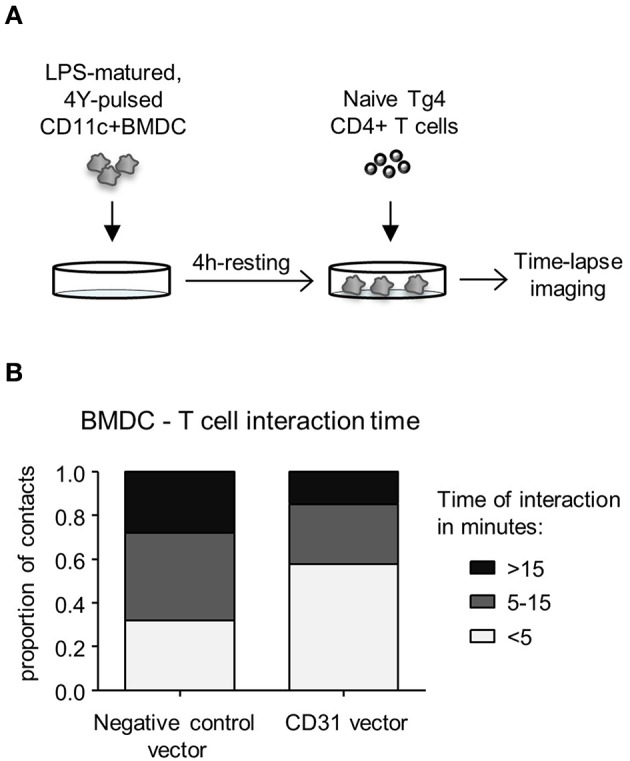
High levels of CD31 on BMDC result in reduced interaction times with CD4+ T cells in vitro. Bone marrow derived dendritic cells (BMDC) were generated over 9 days with 20 ng/ml GM-CSF in the absence (Veh) of 1,25(OH)2D3. On day 6, BMDC were transduced with negative control vector containing a scrambled siRNA or CD31 expressing lentiviral constructs, all expressing GFP. (A) Experimental layout; on day 9, transduced BMDC were sorted for CD11c+GFP+ cells and matured for 4 h in the presence of 0.1 μg/ml LPS and pulsed with 0.1 μg/ml 4Y peptide. Matured BMDC were rested for 4 h and Tg4 CD4+ T cells added at a 1:4 ratio prior to time-lapse imaging. (B) The length of BMDC—T cell interaction was calculated based on images taken in 30 s intervals for the duration of 3 h and were classified as short (< 5 min), intermediate (5–15 min) and long (>15 min). Data pooled from three mice. Representative of 2 experiments.